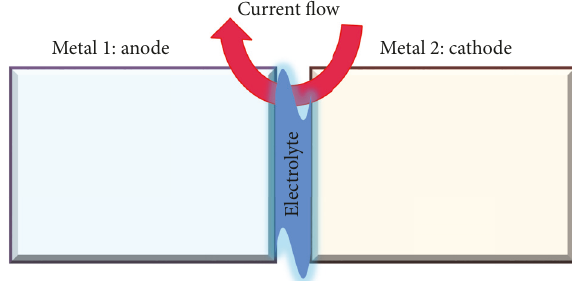
Scheme 1: Electrochemical cell configuration for bimetallic corro-